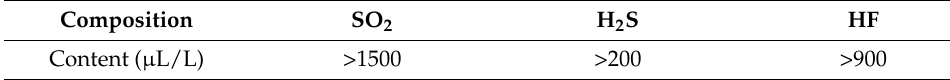
Table 7. Test results of SF 6 gas composition of 550 kV circuit breaker.